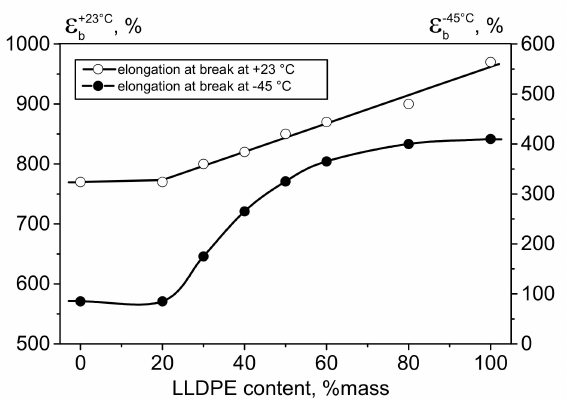
Figure 11. The effect of weight fraction of LLDPE in HDPE on relative elongation at break at +23 and − 45 ◦